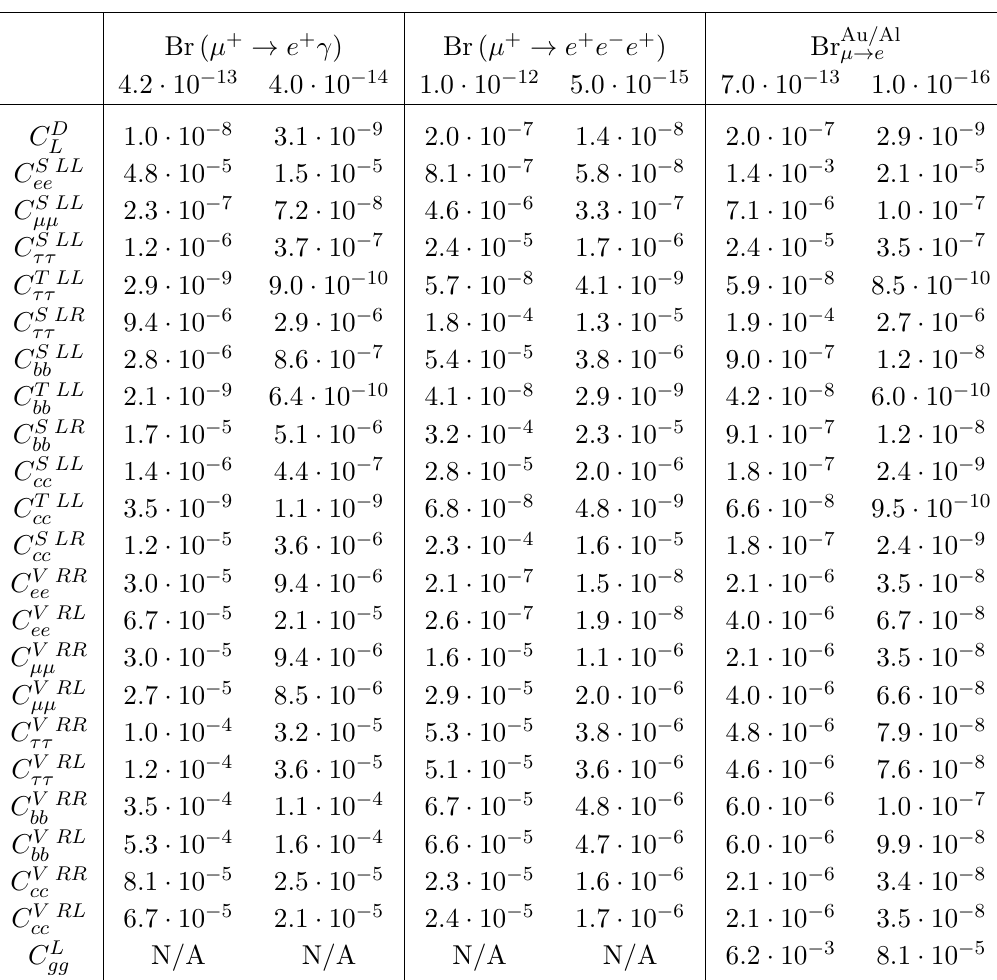
Table 3. Limits on the various coe(cid:14)cients C i ( m W ) from current and future experimental con- straints, assuming that (at the high scale m W ) only one coe(cid:14)cient at a time is non-vanishing and not including operator-dependent e(cid:14)ciency